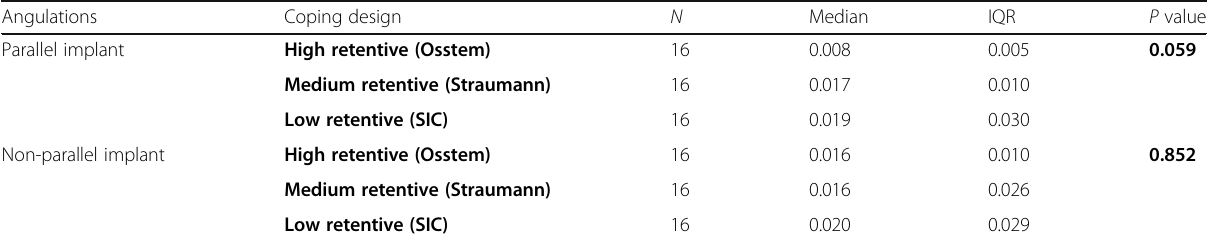
Table 2 Effect of implant angulation on the accuracy in the open tray coping design in the horizontal measurements